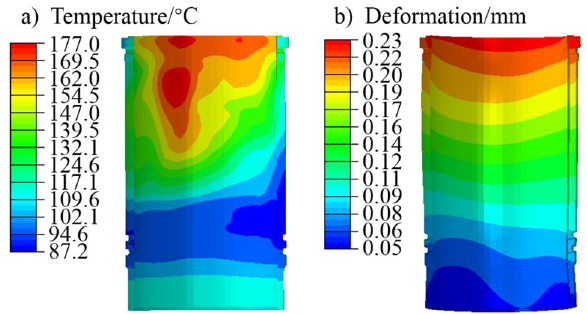
Figure 6. Cylinder liner simulation results of ( a ) temperature, and ( b )